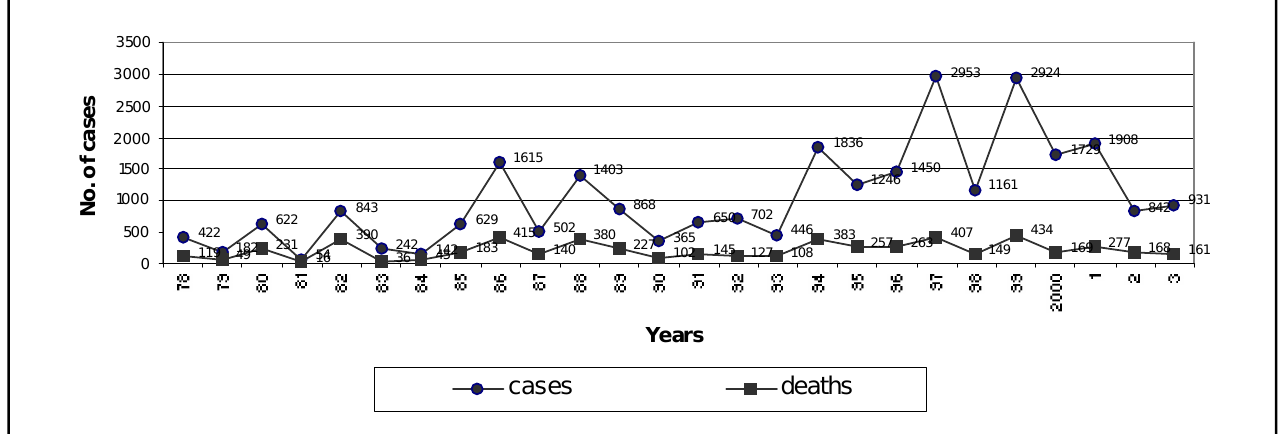
Fig. 2 : Distribution of JE Cases & Deaths During Period 1978-2003,